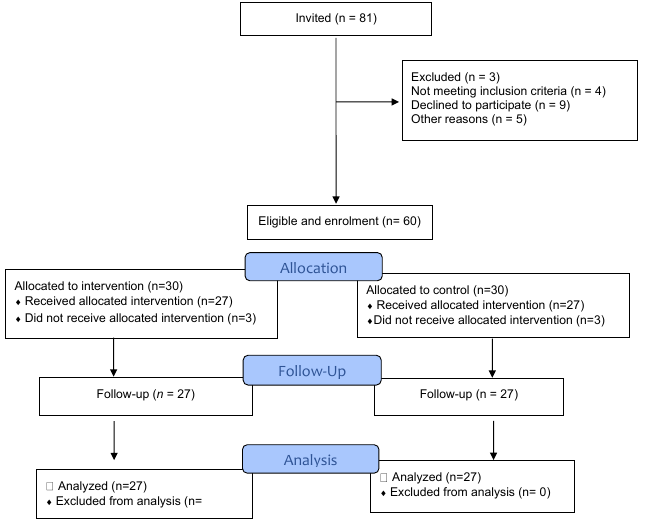
Figure 1. The flowchart of the study.